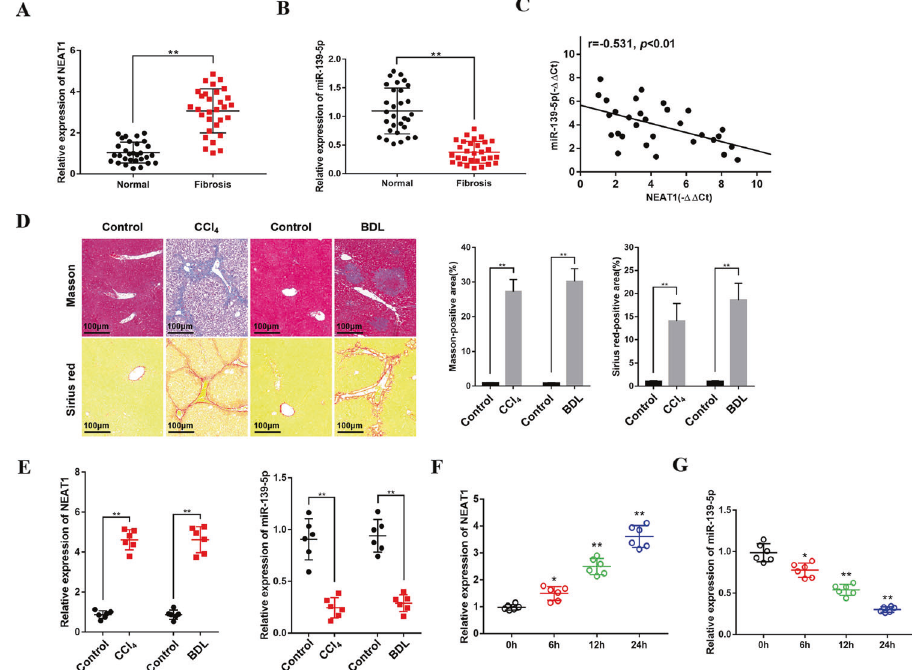
Fig. 1 Expression of NEAT1 is upregulated and miR-139-5p is downregulated in liver fi brosis. A The expression of NEAT1 was upregulated in human liver fi brosis tissues. n = 30/group. B The expression level of miR-139-5p was downregulated in human liver fi brosis tissues. n = 30/ group. C The correlation between NEAT1 and miR-139-5p expression levels in fi brotic liver tissues from patients was evaluated with Pearson ’ s correlation analysis, n = 30. D The liver tissues from mice treated with CCl 4 for 8 weeks and BDL for 2 weeks were performed with Masson staining and Sirius red staining. n = 6/group, original magni fi cation×200. E The expression level of NEAT1 was upregulated and the expression level of miR-139-5p was downregulated in murine liver fi brosis tissues. n = 6/group. F The expression level of NEAT1 was upregulated in activated LX-2 cells stimulated with 10 ng/mL TGF- β 1 in a time-dependent manner. n = 6/group. G The expression level of miR-139-5p was decreased in activated LX-2 cells stimulated with 10 ng/mL TGF- β 1 in a time-dependent manner. n = 6/group. Graph represents mean ± SD. * P < 0.05, ** P <